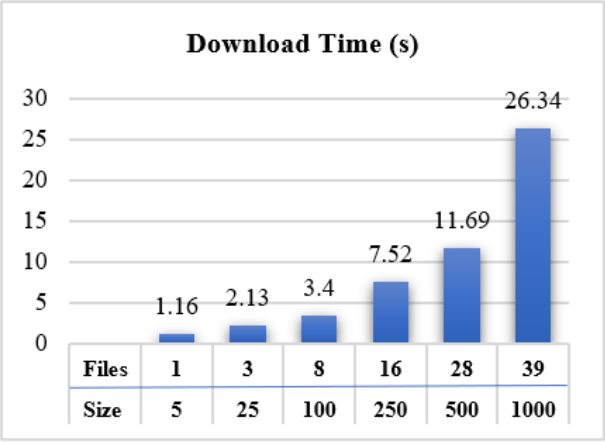
Figure 11. Downloading performance in seconds.